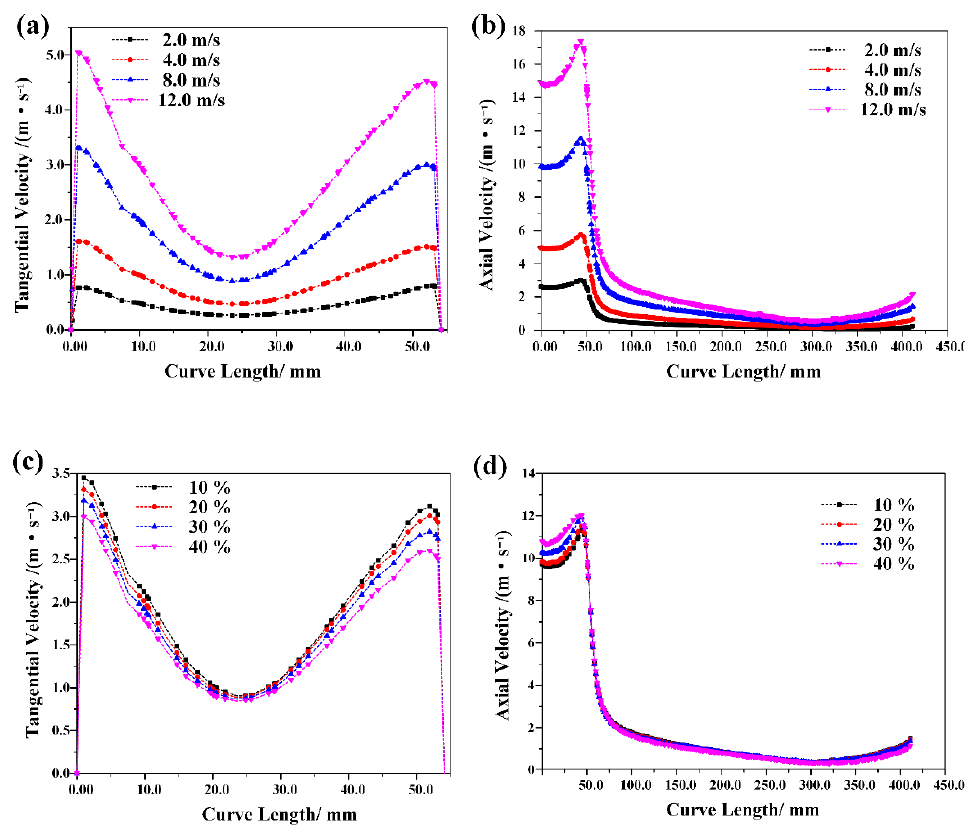
Figure 4. The velocity distribution of tar vapor. ( a ) Tangential velocity with water content of 20%, ( b ) axial velocity with water content of 20%, ( c ) tangential velocity when inlet velocity is 8.0 m/s, and ( d ) axial velocity when inlet velocity is 8.0 m/s.